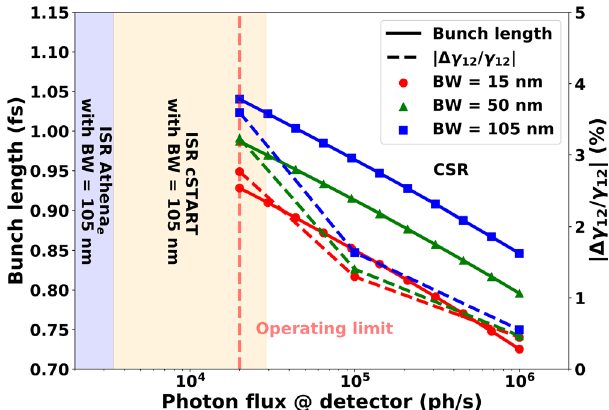
(cid:5) (cid:5) (cid:5) (cid:5) ) 12